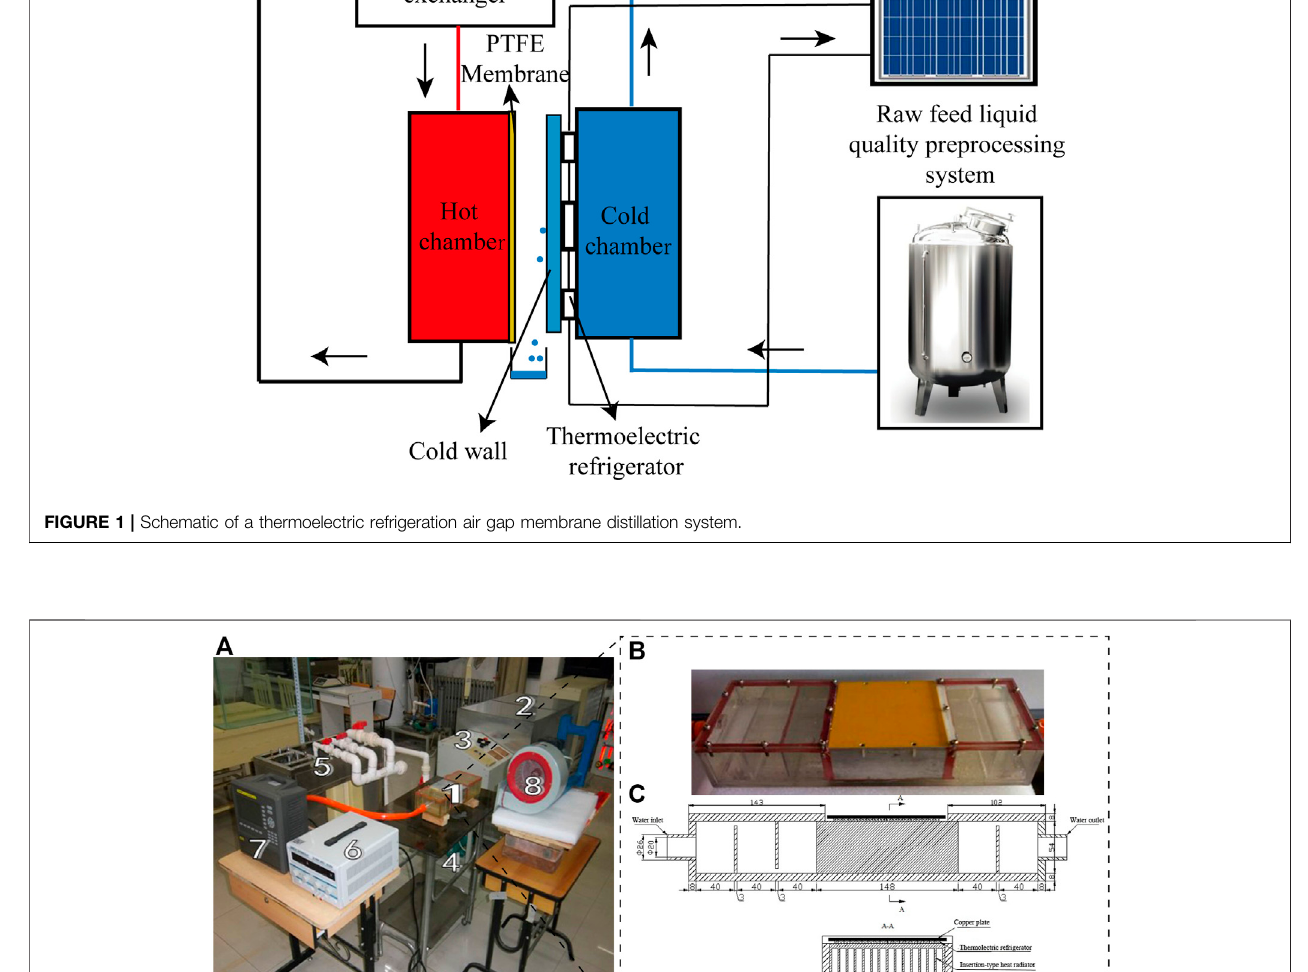
Frontiers in Energy Research |